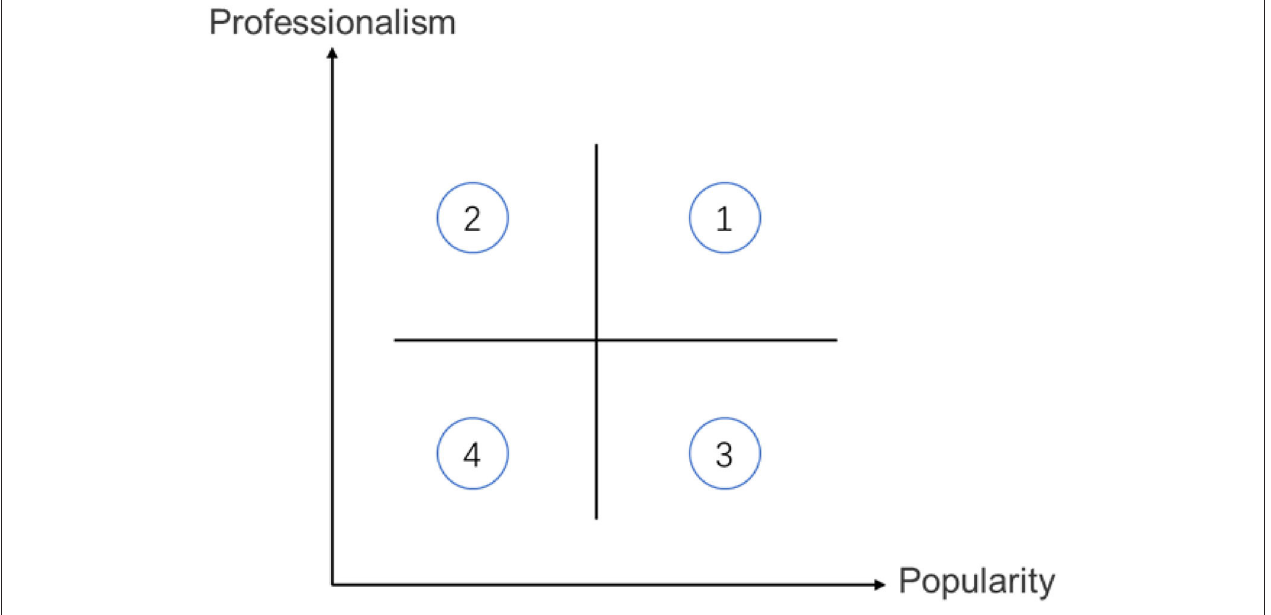
FIGURE 1 | Schematic diagram of the classification of review parties.